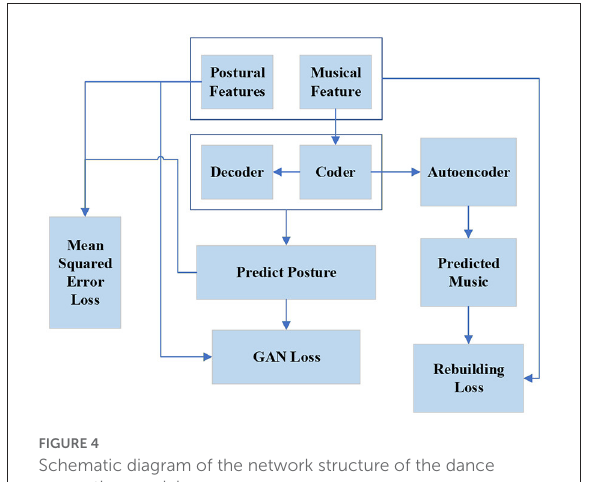
FIGURE4 Schematic diagram of the network structure of the dance generation model.